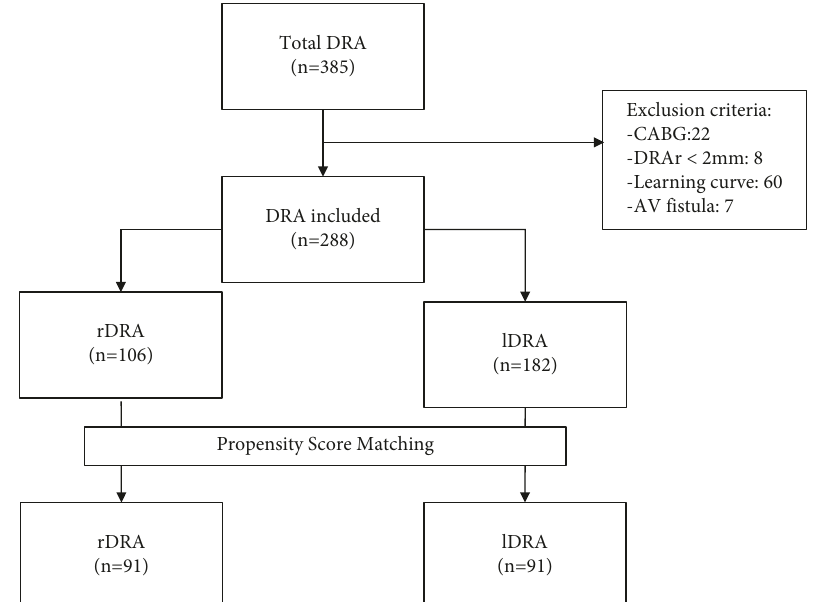
Figure 1: Study flowchart. DRA, distal radial access; CABG, coronary artery bypass graft; DRAr, distal radial artery; AV, arteriovenous; rDRA, right distal radial access; lDRA, left distal radial